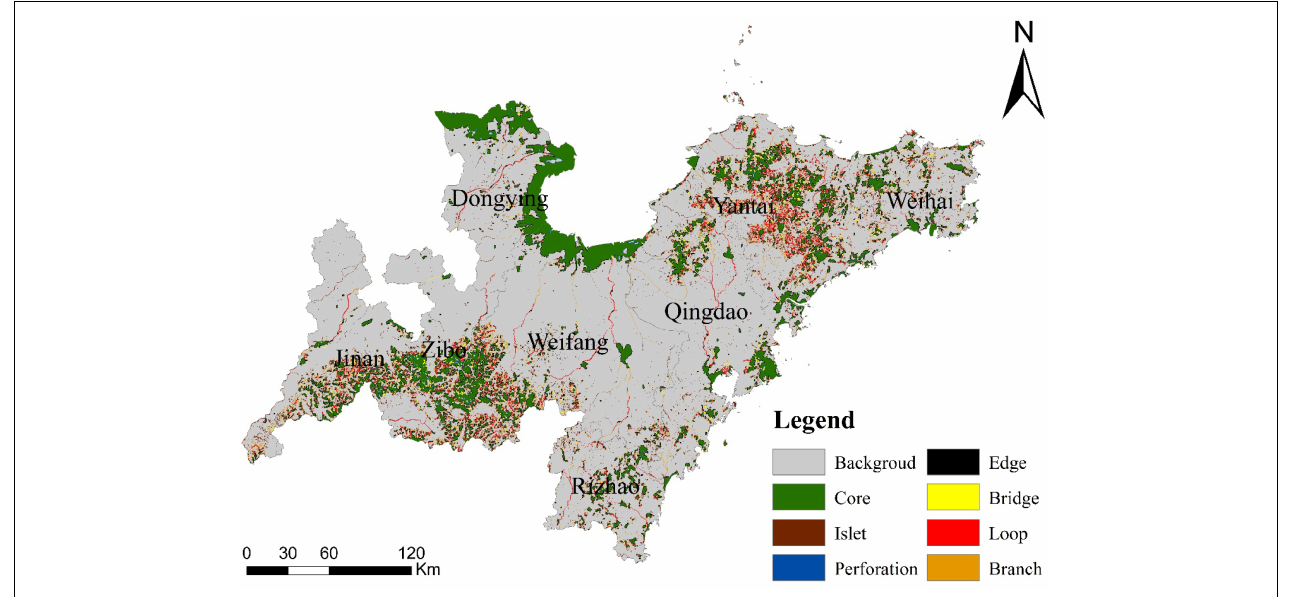
FIGURE 3 | MSPA landscape